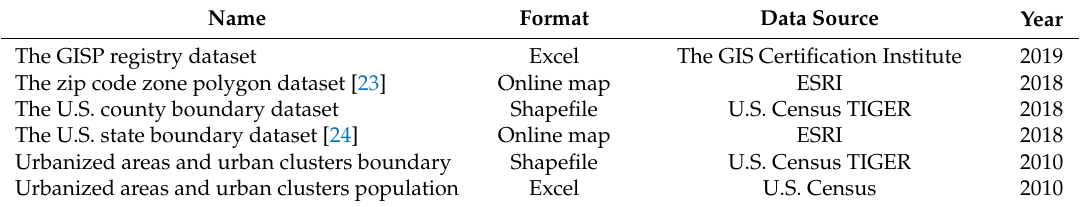
Table 1. A summary of the datasets used in this study. GIS: geographic information systems, GISP: GIS Professional, ESRI: Environmental Systems Research